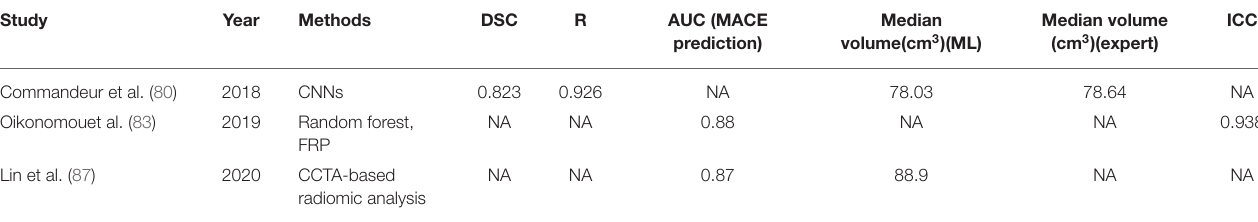
TABLE 7 | Application of artificial intelligence in epicardial adipose tissue and perivascular adipose tissue.